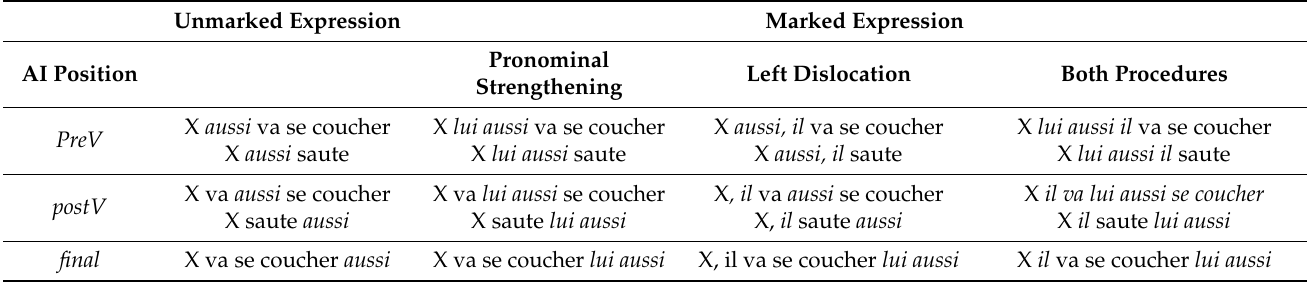
Table 6. Marked expressions of contrastive topics in additive